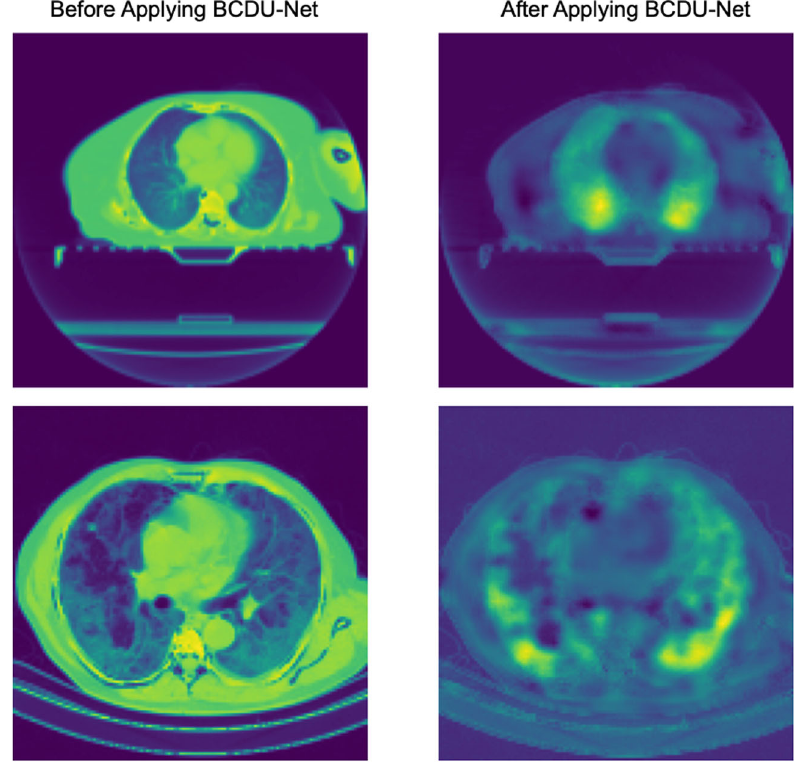
Fig. 2 Covid-19 and CAP infection extraction by BCDU-Net. The fi ltered images (left) will be used for classi fi cation by CNN. An unprocessed 3D image of the whole lung infected with Covid-19 is shown in Fig. 3a. The same image was processed with BCDU-Net to remove non lung- related parts and to extract and highlight the Covid-19 infection (Fig. 3b).